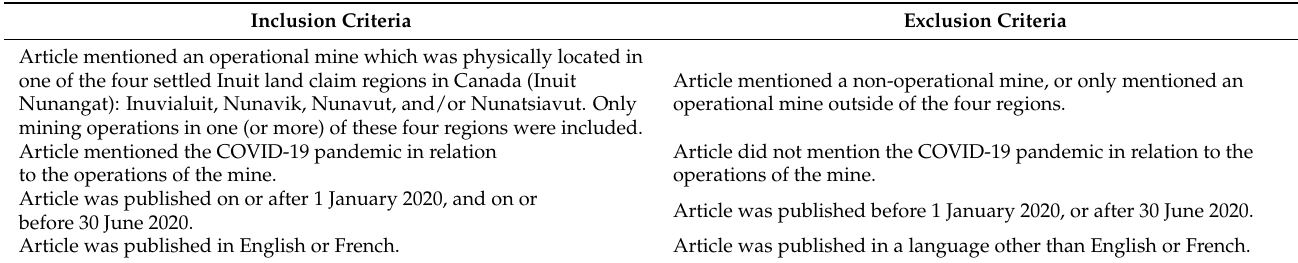
Table 2. Inclusion and exclusion criteria used to identify relevant articles on mining industry’s initial response to COVID-19 in Inuit Nunangat from 1 January 2020, to 30 June 2020. Inclusion Criteria Exclusion Criteria